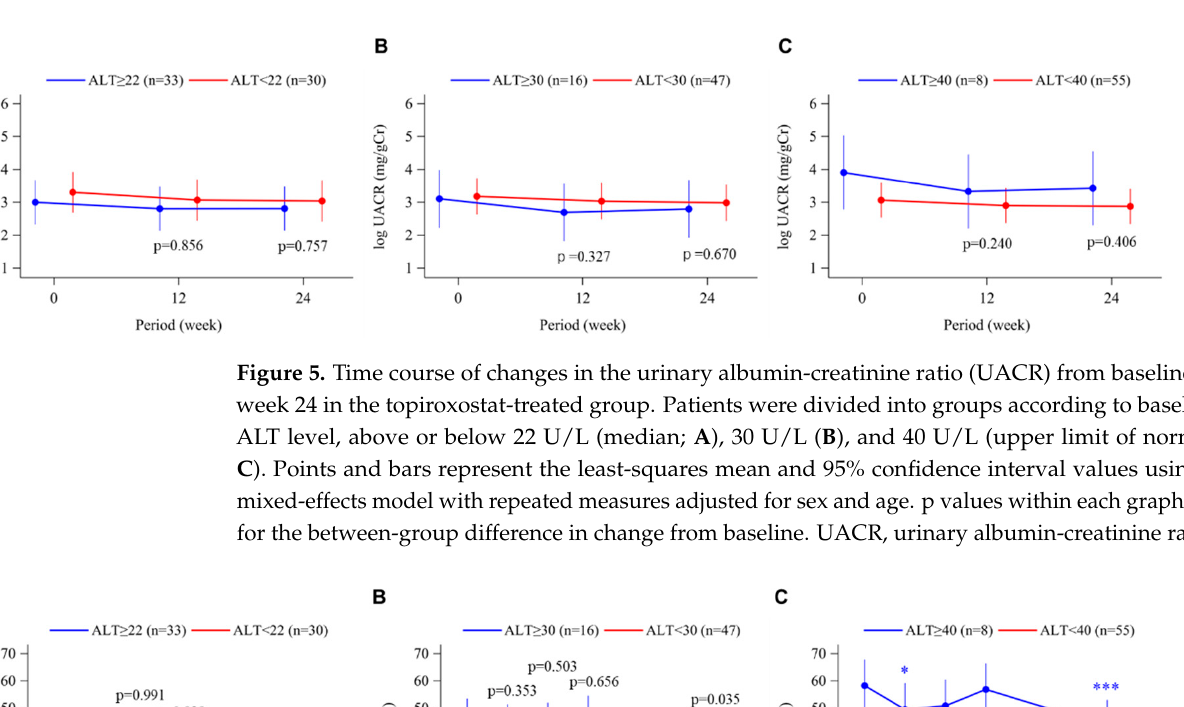
Figure 4. Time course of changes in plasma xanthine oxidoreductase activity (XORA) from baseline to week 24 in the topiroxostat-treated group. Patients were divided into groups according to base- line alanine aminotransferase (ALT) level, above or below 22 U/L (median; A ), 30 U/L ( B ), and 40 U/L (upper limit of normal; C ). Points and bars represent the least-squares mean and 95% confidence interval using the mixed-effects model with repeated measures adjusted for sex and age. p-values within each graph are for the between-group difference in change from baseline. *** p < 0.001 for change from baseline in the ALT-high group. †† p < 0.01 for change from baseline in the ALT-low group.